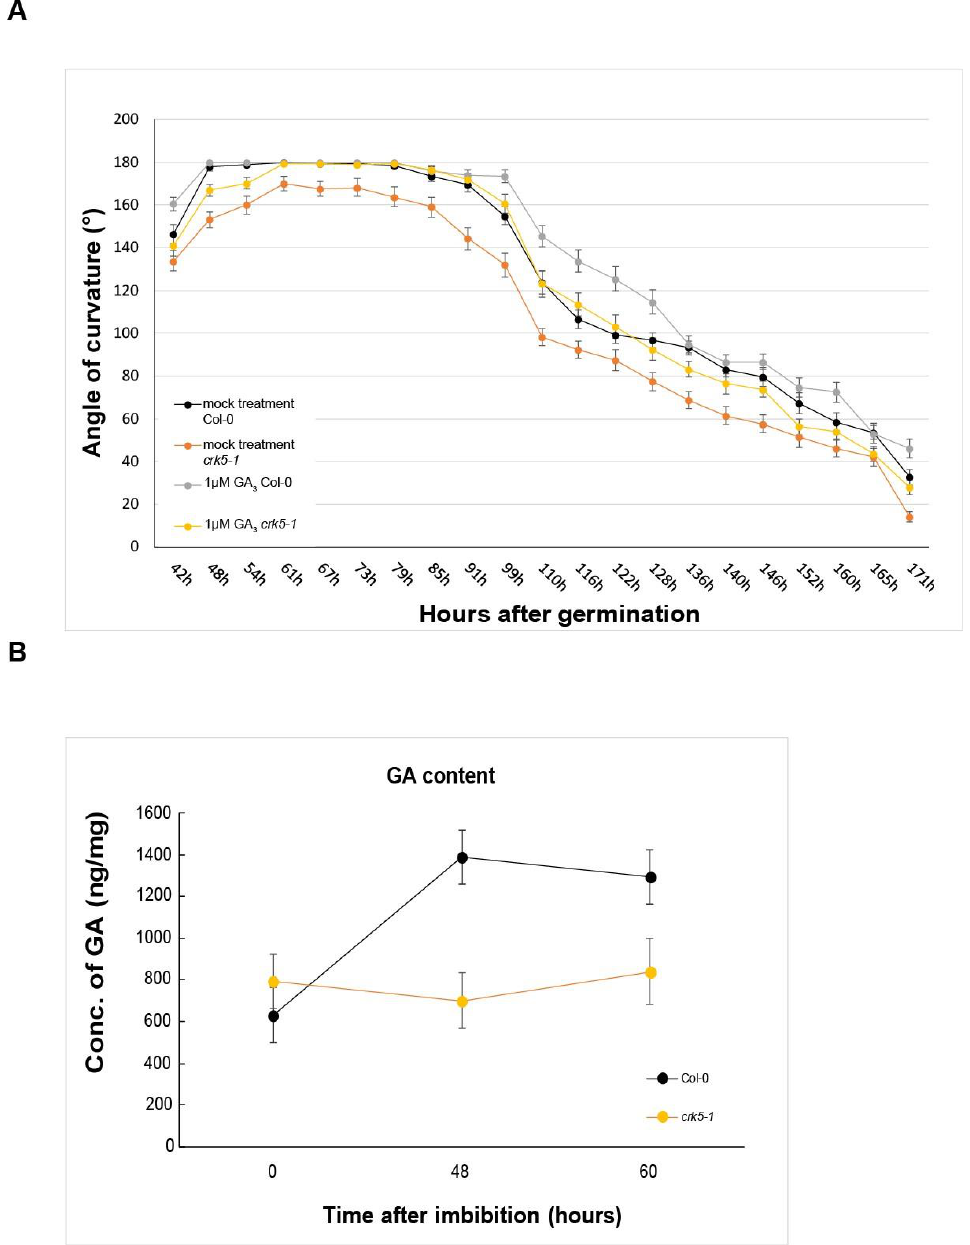
Figure 2. Kinetics of exogenous GA 3 -regulated apical hook development and measurement of the total GA content. ( A ) Kinetics of hypocotyl hook development in wild type Arabidopsis (Col-0) and in mutant At crk5-1 seedlings germinated in dark in the absence and presence of 1 µ M GA 3. The experiments were carried out twice with the same results. The averages and standard error (SE) are shown of two biological replicates using minimum 35 seedlings per genotype per experiment. The mutant values are significantly di ff erent at all the time period tested in comparison with the wild type (Student’s t -test: P < 0.01). ( B ) Determination of total gibberellic acid concentrations in seeds and dark-grown seedlings of the wild type (Col-0) and the mutant (At crk5-1 ). Total GA content was measured in dried seeds (0 h), and in seedlings at hook formation (48 h) and at the beginning of the hook maintenance phase (60 h). Two biological repeats were